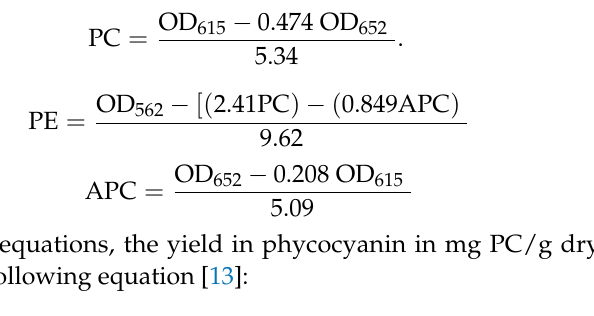
Figure 6. Growth curve and pH values for the period of a culture of Phormidium sp. at a salinity of 40 ppt in two light regimes: “ high light ” - “ XL ” -8000 lux and “ low light ” - “ L ” -2000 lux.